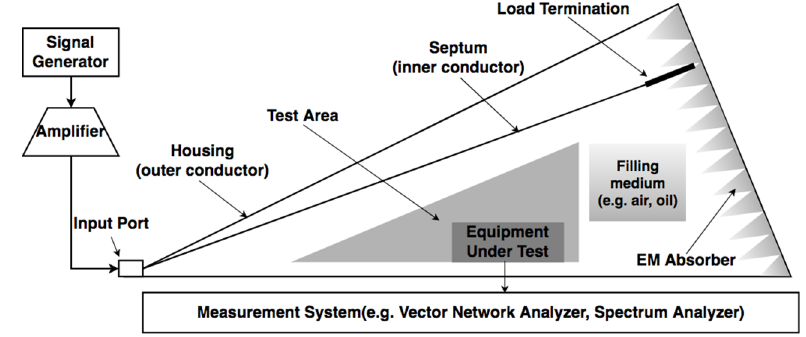
Figure 8. GTEM cell for UHF sensor sensitivity testing.